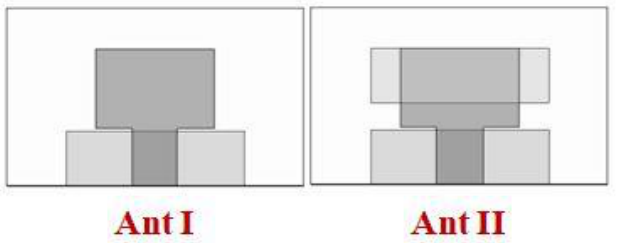
Figure 14. Evolution of the antennas linked with P18 to P24.